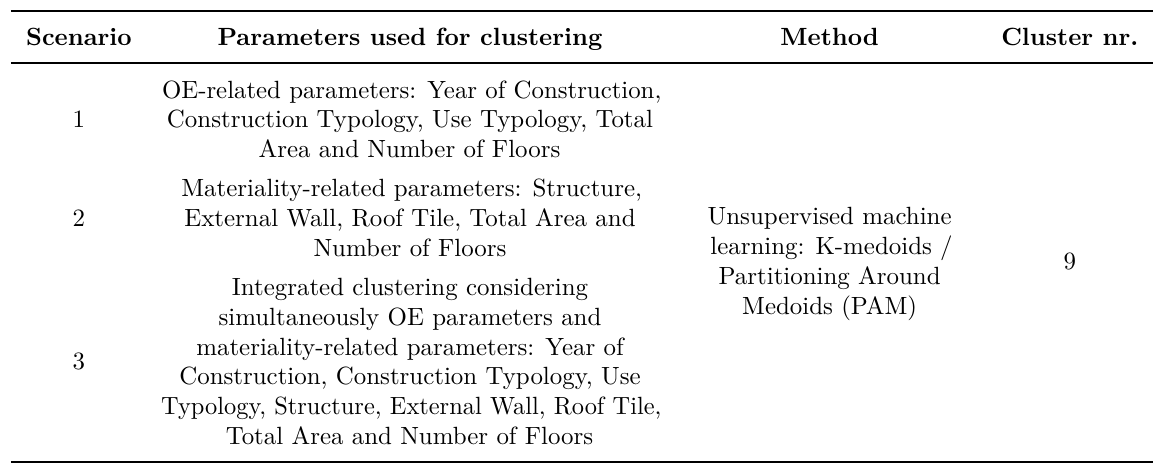
Table 1. Description of the clustering scenarios.